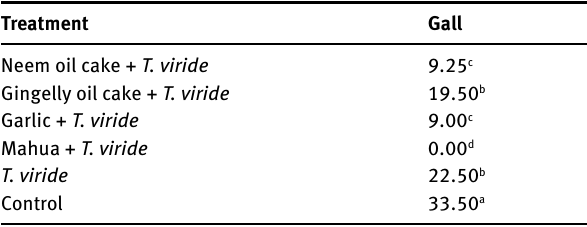
Table 4: Effect of oil cakes and garlic based T. viride preparation on root knot nematode formation on chilli Treatment